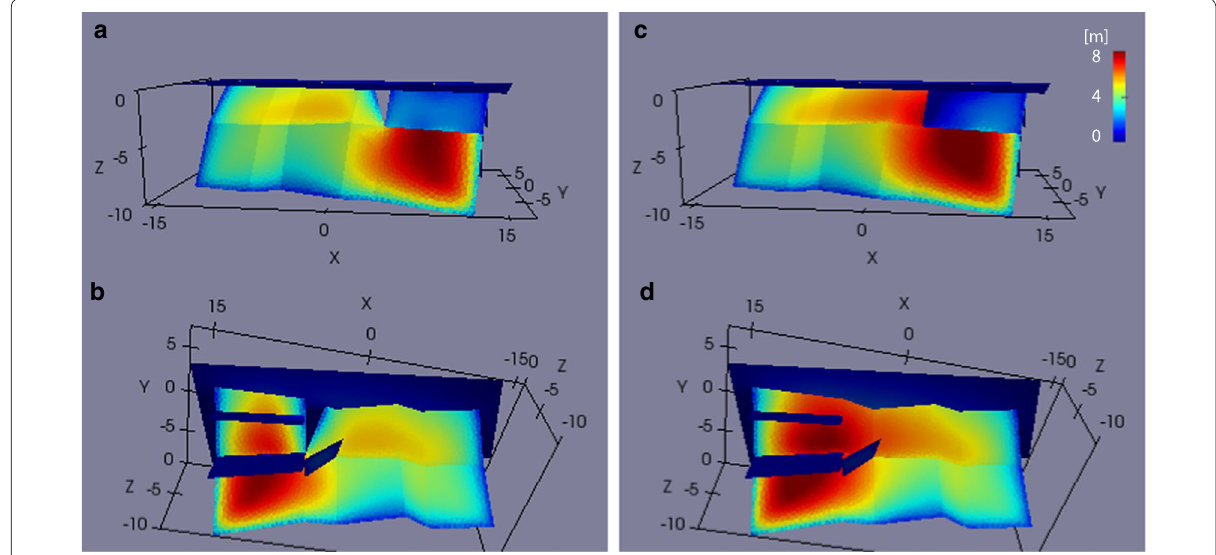
Fig. 9 Spatial distribution of final slip for Models S ( a , b ) and C ( c , d ). View from east ( a , c ) and looking up from west ( b , d